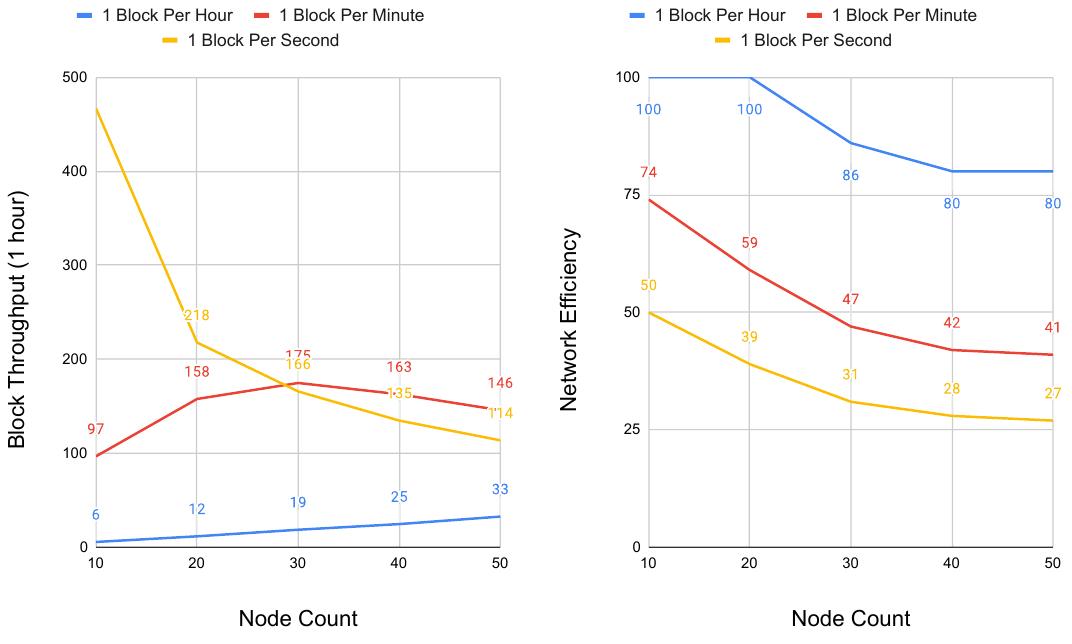
Figure 9. Performance and scalability of Conte at 15,000 km node distances and maximum hops to graph edge of 50. Block Throughput ( left ) and Network Efficiency ( right